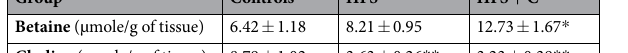
Group Controls HFS HFS + C Betaine ( µ mole/g of tissue)